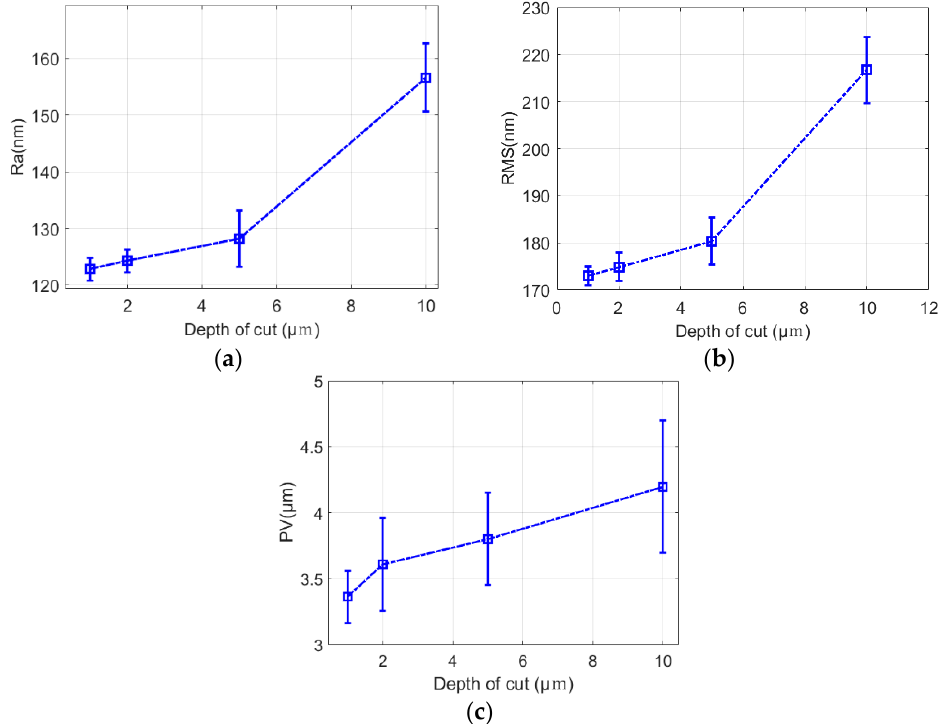
Figure 12. Effects of grinding marks on surface quality for different cutting depths. ( a ) Ra . ( b ) RMS . ( c ) PV.